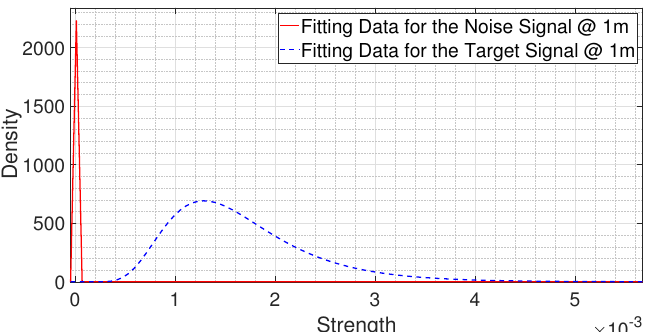
Figure 10. The fitting results for the noise signal and the signal reflected from the person at 1